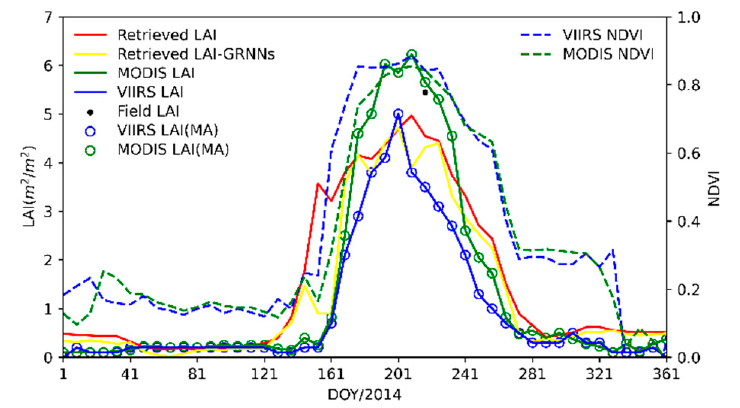
Figure 13. Temporal trajectories of the LAI-TCA and the LAI-GRNN at the center pixel of the Albufera site for 2014.